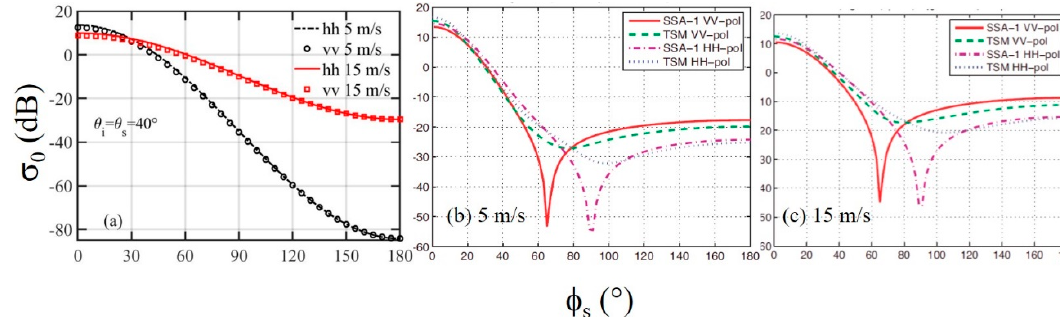
Figure 16. ( a ) Examples of NRCS dependence on ϕ s , f = 14 GHz, θ i = θ s = 40°, U 10 = 5 and 15 m/s; ( b ) and ( c ) are the SSA and TSM solutions reproduced from Figure 8 of A06 for U 10 = 5 and 15 m/s, respectively.